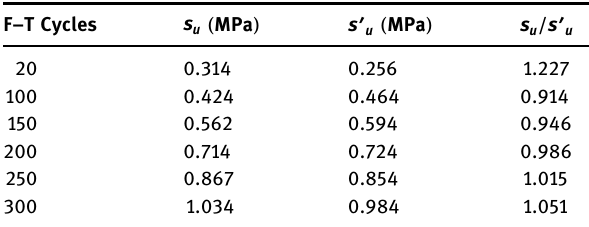
Table 4: Bond slip experimental values ( ) s u and bond slip